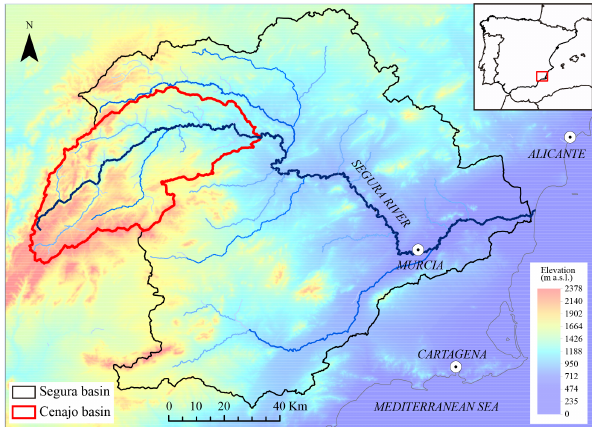
Table 1. Regional and global climate models